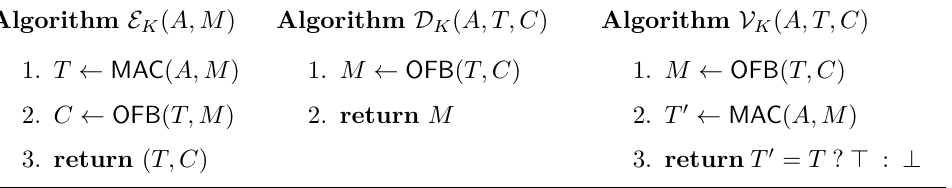
Figure 1: Encryption, decryption and verification algorithm of